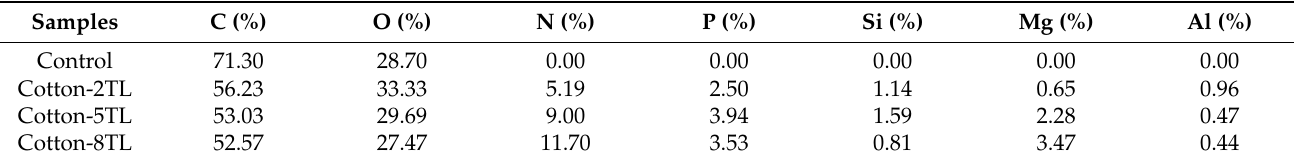
Table 1. Atomic concentrations of all cotton fabrics measured by